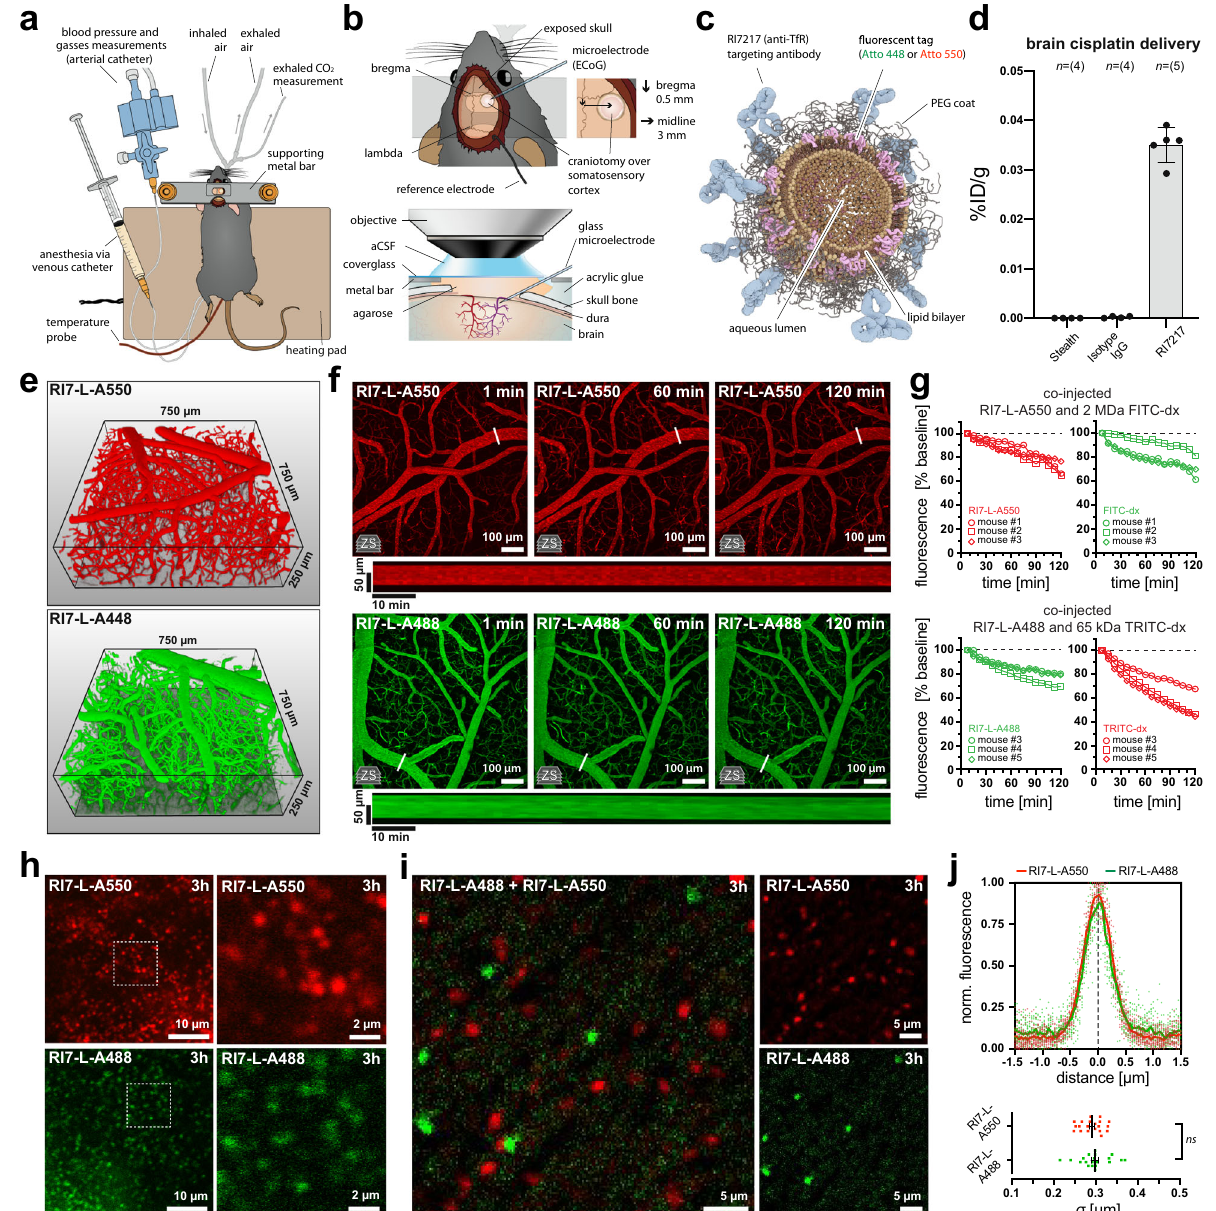
Fig. 1 Two-photon imaging of liposome nanoparticles in vivo. a Schematic drawing of a mouse after the preparative surgery. b Mouse head with the location of craniotomy and the main features of the cranial window. c Principal components of nanoparticles used in the study. d Nanoparticles functionalized with RI7217 antibody drive accumulation of cisplatin payload in the brain, in contrast to nanoparticles with isotype IgGs, and nanoparticles devoid of antibody (stealth). %ID/g is the percentage of the injected dose of nanoparticle-encapsulated cisplatin per gram brain tissue measured 2 h post i.v. injection with ICP-MS; n stealth,IgG = 4 mice, n RI7217 = 5 mice. e Brain somatosensory cortex volume imaged in the study. Example 3D reconstructions show brain microvessels delineated by fl uorescence of blood-circulating nanoparticles. f Hyperstack (Z-stack over time) images of fl uorescence signal from nanoparticles after injection into the bloodstream. Time is relative to the time of injection. Long panels are kymographs of fl uorescence changes measured from venules at demarked lines. ‘ zs ’ inset indicates Z-stack maximum intensity projection. See also Supplementary Movie 1. g Fluorescence from blood- circulating RI7-L-A550 and RI7-L-A488 exhibit a relatively high degree of stability over time, being in the range of commonly used tracers in vascular imaging studies, i.e., FITC- and TRITC-dextran. RI7-L-A550 and RI7-L-A488 signals were measured simultaneously with co-injected FITC- and TRITC- dextran, respectively. Traces represent single animals with symbols matching individual mice between corresponding imaging channels. n = 3 mice in each group. h Laser-extravasated nanoparticles into the brain parenchyma 3 h after injection into the circulation. Nanoparticles retain their discrete and homogeneous appearance even after 3 h of circulation. i Laser-extravasated RI7-L-A488 and RI7-LA550 into the brain parenchyma 3 h after co-injection into the circulation. Lack of merged fl uorescence signal from nanoparticles indicates no liposome fusion or aggregation when in circulation or in the brain. j The averages of nanoparticles fl uorescence pro fi le plots after laser-extravasation into the brain. The average standard deviations ( σ ) of Gaussian pro fi les describing fl uorescence signal distribution do not differ between distinctively labeled nanoparticles. n = 20 vs. 20 nanoparticles extravasated in 1 mouse per nanoparticle type, p = 0.5910, two-tailed t -test. All panels: ns non-signi fi cant. Data are means± SEM.